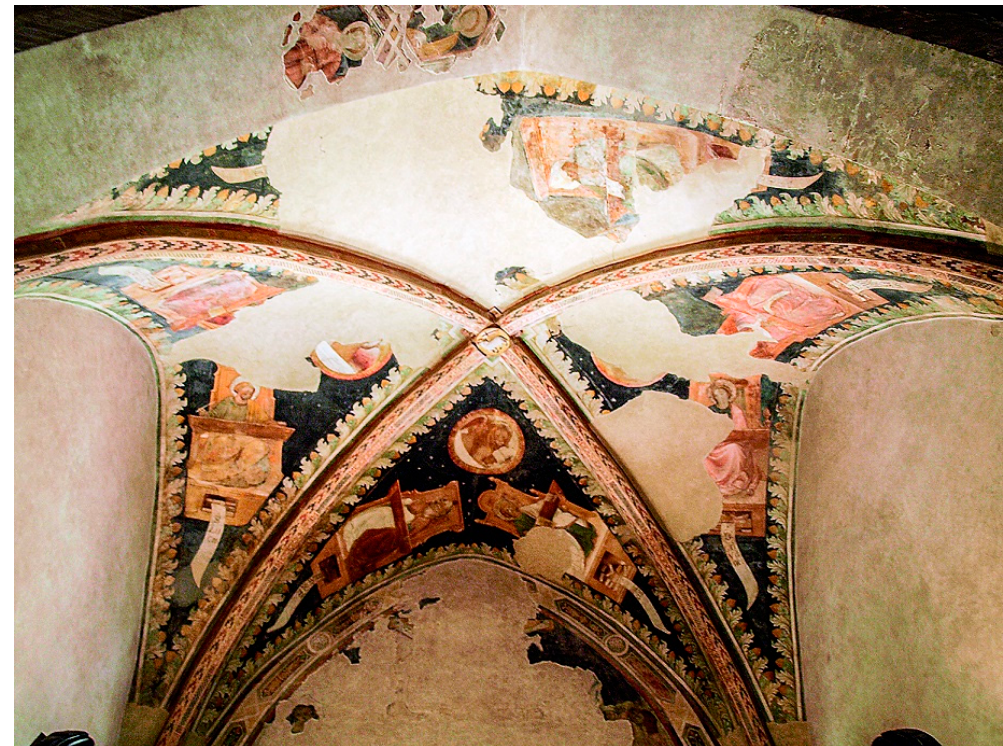
Figure 8. Ravenna, the church of San Giovanni Evangelista, north chapel (second quarter of the 14th century?), fot. R. Quirini-Pop ł awski (2016).